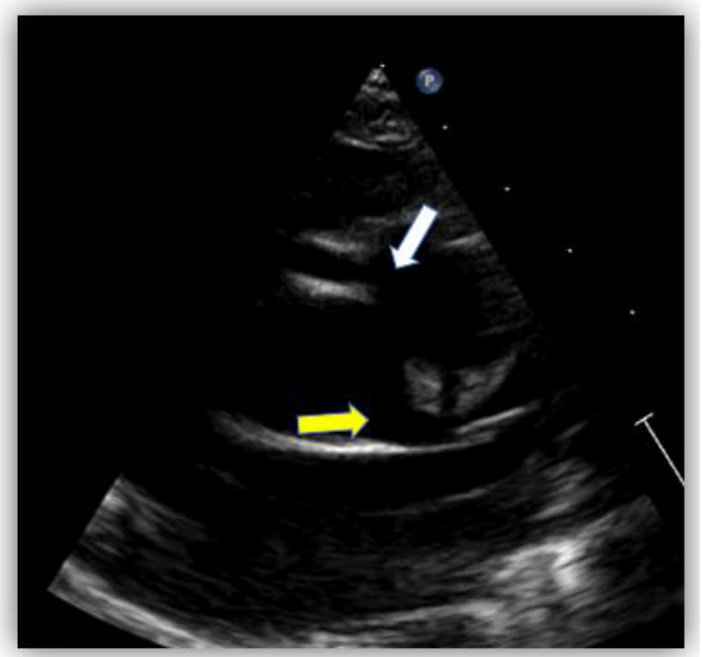
Figure 2. Echocardiography in the parasternal short-axis view. The white arrow shows the origin of the right coronary artery (RCA) from the pulmonary artery and the yellow arrow shows the normal origin of the left coronary artery (LCA) from the aorta.